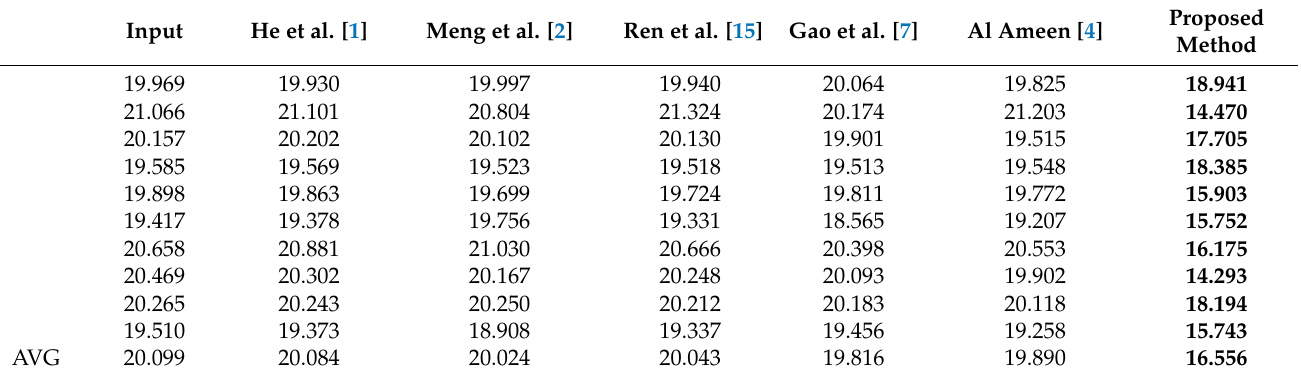
Table 5. The comparison of the NIQE [33] scores from Figure 7 (If the score is low, the image is well enhanced. The lowest are indicated in bold